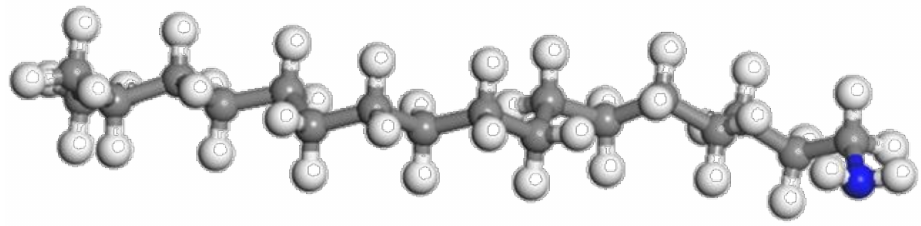
Figure 3. Molecular structure of